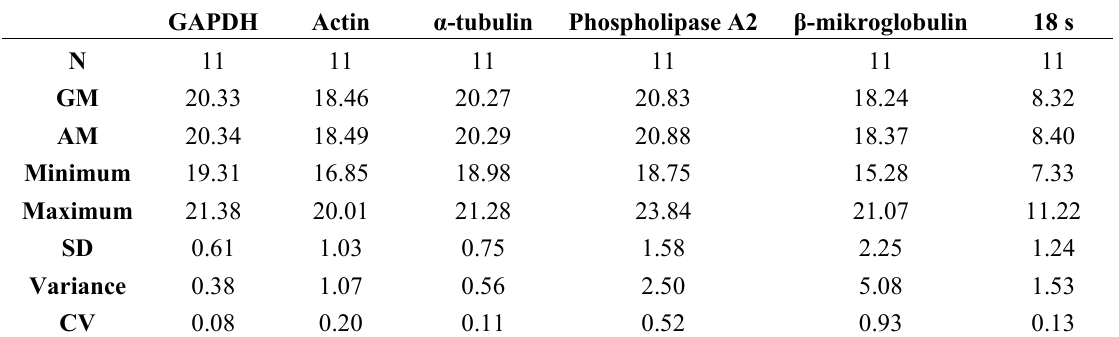
Table 3. Descriptive statistics of 18s ribosomal unit reference gene based on its crossing